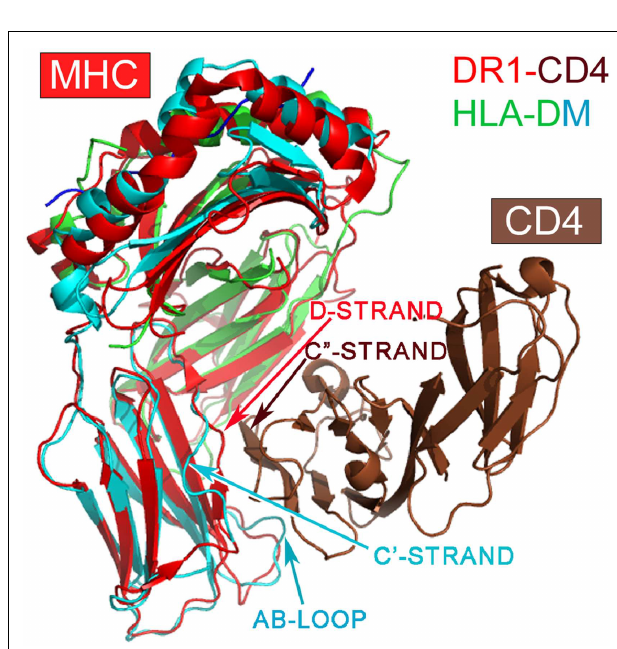
FIGURE 2 | Conserved inter-domain interface in the MHCII molecule HLA-DQ8 (1JK8) that maintains the inter-domain orientation for CD4-binding . (A) The overall view of HLA-DQ8.The gold color indicates the α